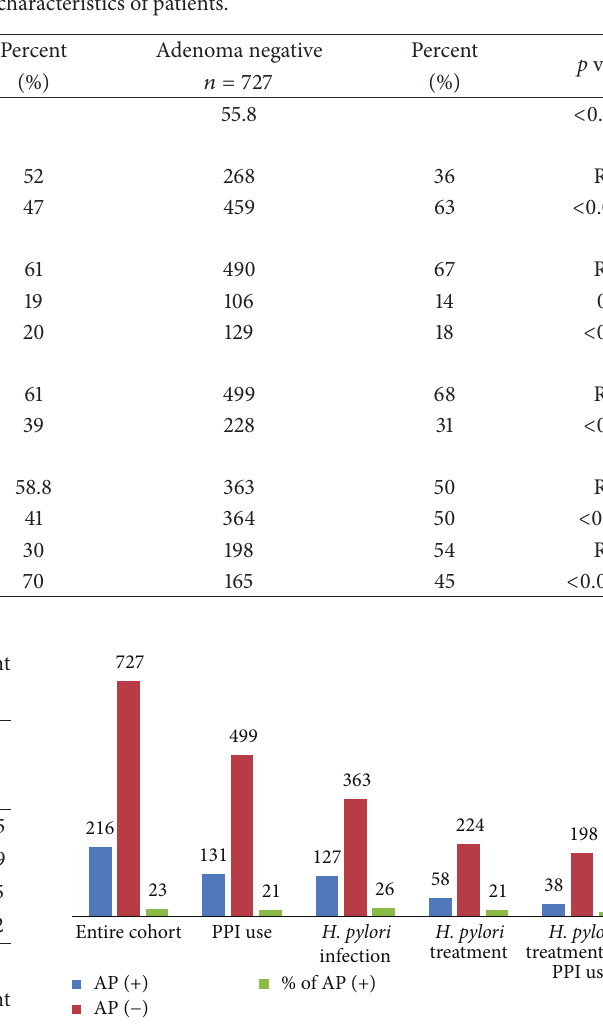
Table 1: Baseline characteristics of patients.